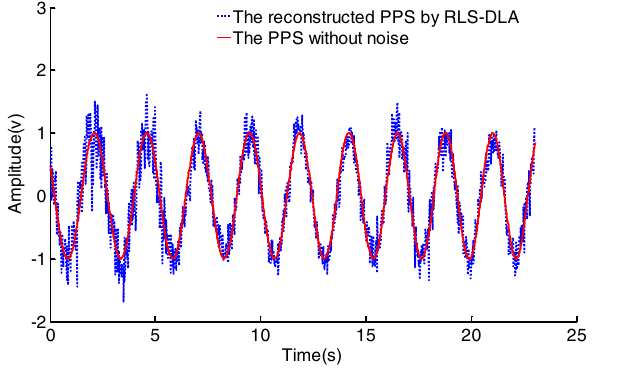
Figure 9. Reconstructed signal by RLS-DLA.